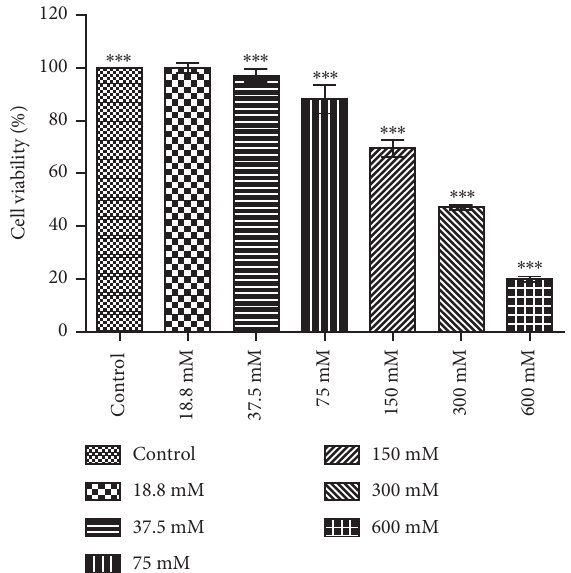
Figure 2: Cytotoxicity effect of H 2 O 2 on SH-SY5Y cells exposed to different concentration (18.8–300mM). The percentage of cells viability is shown versus concentration of the tested H 2 O 2 . ∗∗∗ p < 0 . 001 represented significantly different values from control and tested samples. The values represent mean ± SD from three ( n � 3) independent experiments.